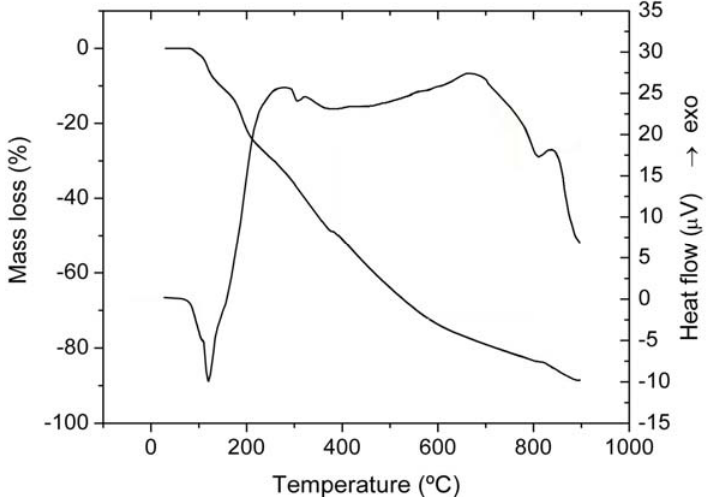
O) ](SO ) O.  2H 2 2 4 0.5 2